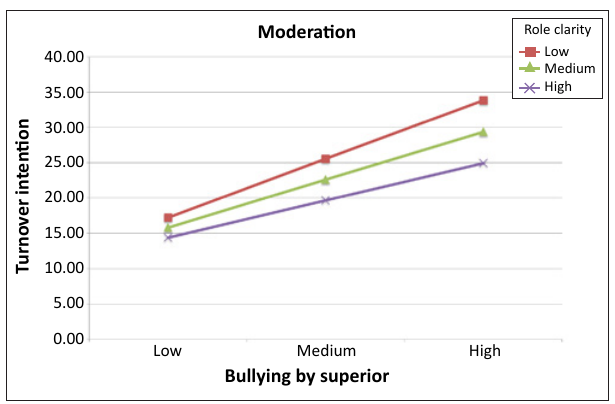
FIGURE 1: Interaction of bullying by superiors with role clarity in relation to turnover